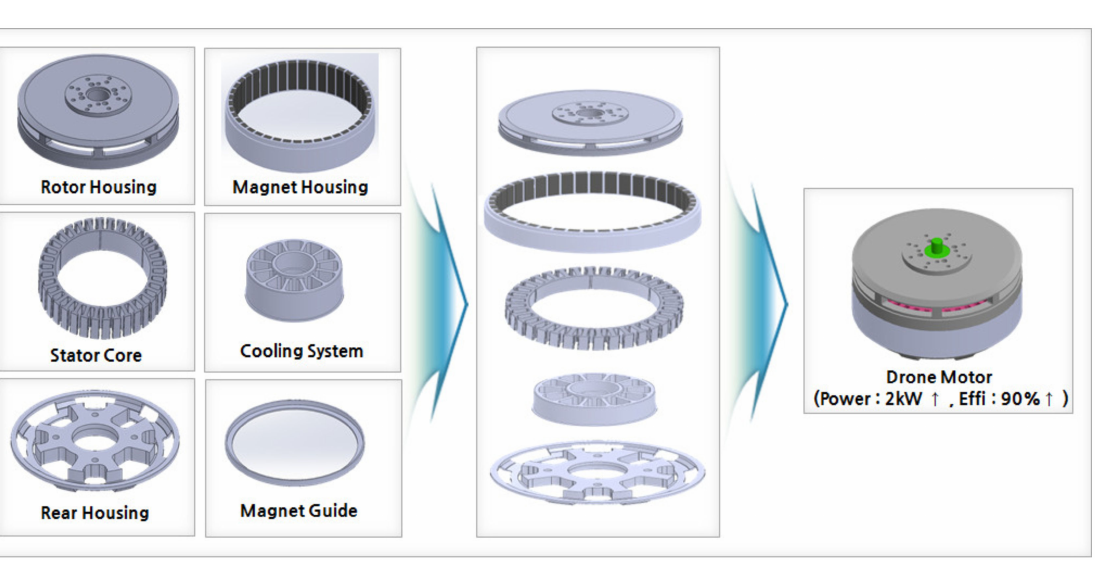
Figure 6. UAV motor prototype